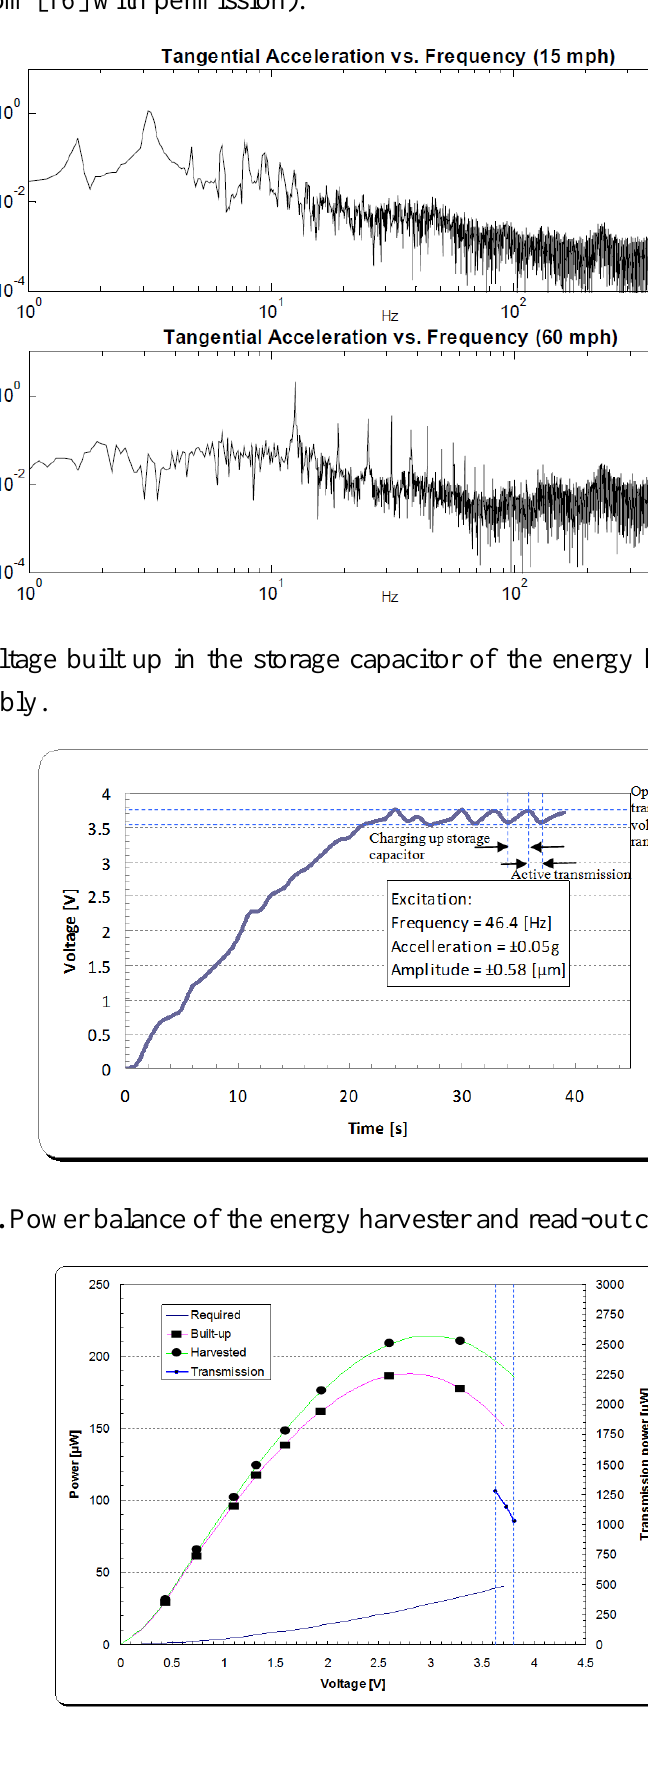
Figure 26. Tangential acceleration spectrum at 15 and 60 mph (24 and 96 km/h) (reproduced from [16] with permission).